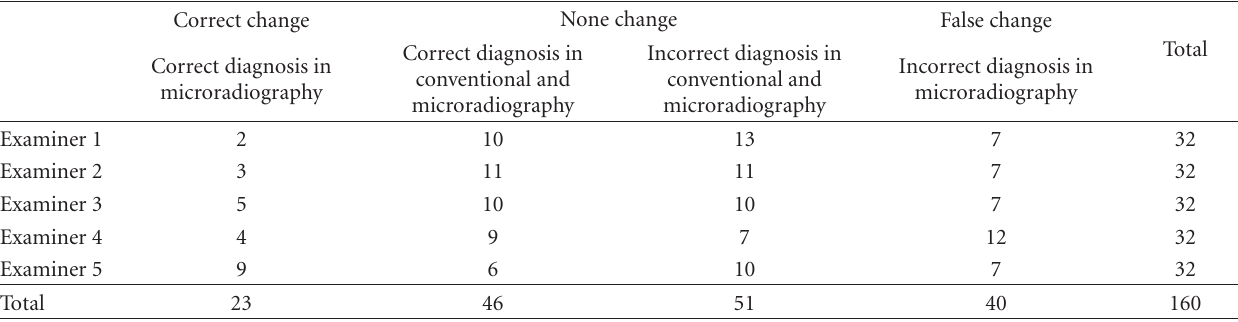
Table 3: Change of diagnosis by microradiography.